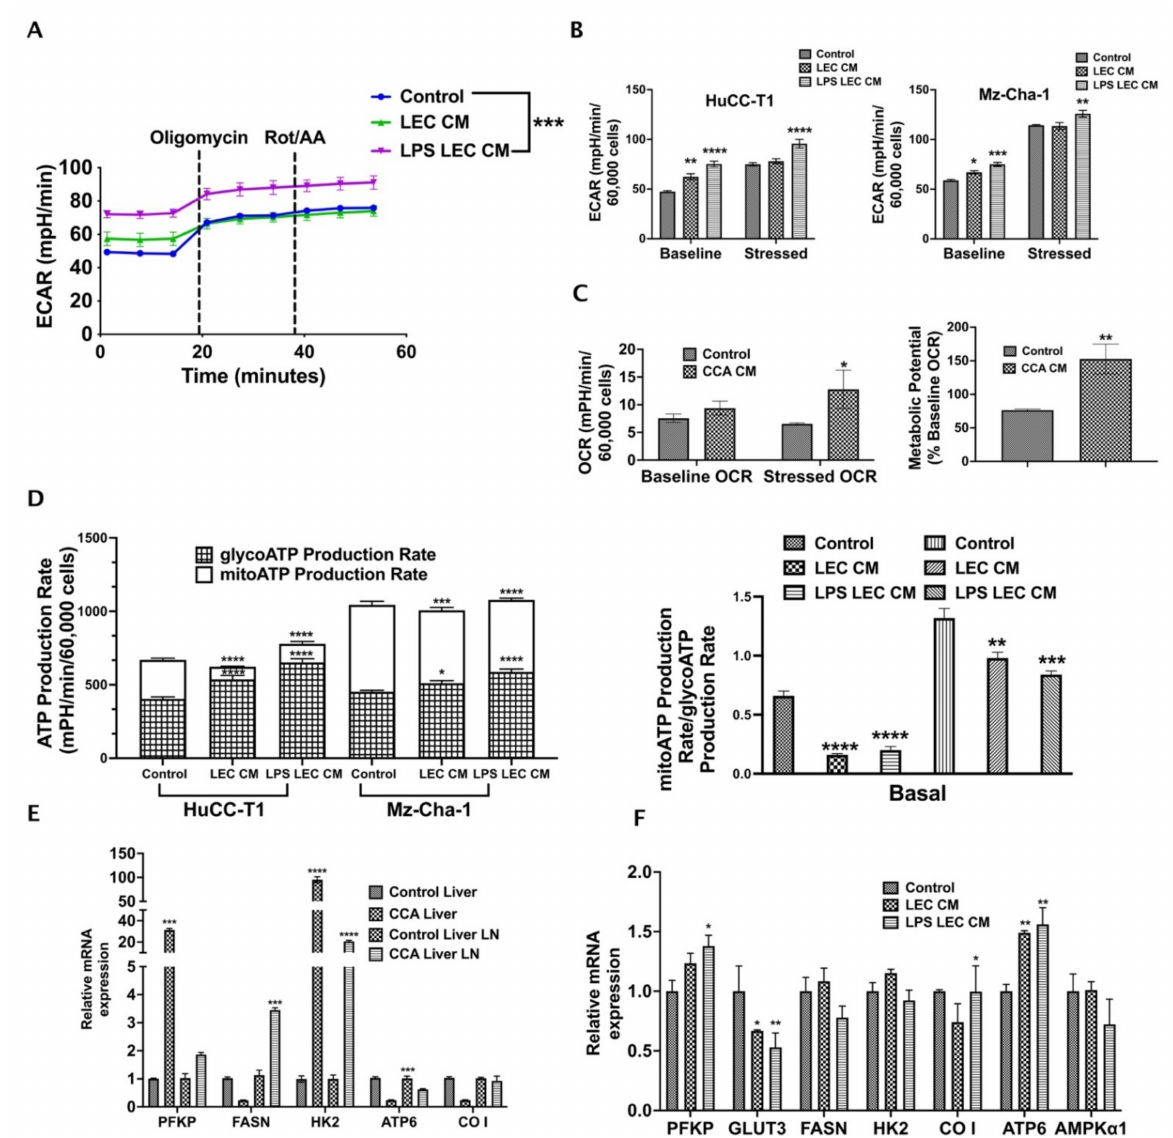
Figure 5. Crosstalk with inflamed LECs alter cellular bioenergetics and critical metabolic gene expression in CCA cells. CCA cells were treated with LEC/LPS-LEC-CM or 5%EGM and Seahorse assay was performed to follow the glycolysis. ( A ) Graph for Extracellular acidification rate (ECAR) of all groups was obtained using Wave software. The time points by which Oligomycin and Rot/AA were injected were depicted in the graphs. The ECAR at time points before Oligomycin injection is associated with glycolysis while that post Oligomycin injection is associated with maximal glycolytic capacity. Values are represented as mean ± SEM, n ≥ 3. *** represents value significantly different than control at p ≤ 0.001 ( B ) Comparison of baseline vs. stressed ECAR between LEC-CM/LPS-LEC-CM treated CCA cells. * p ≤ 0.05, ** p ≤ 0.01, *** p ≤ 0.001 and **** p ≤ 0.0001 represents value significantly different than control. ( C ) Comparison of baseline and stressed OCR in CCA-CM treated LECs. Lower panel, right, shows metabolic potential of CCA-CM LECs. Values are represented as mean ± SEM, n ≥ 3. * p ≤ 0.05 and ** p ≤ 0.01represents value significantly different than control. ( D ) Left panel shows comparison between glycolytic and mitochondrial ATP production rate in LEC-CM/LPS-LEC-CM treated CCA cells. Right panel shows comparison between ATP rate index between LEC-CM/LPS-LEC-CM treated CCA cells. * p ≤ 0.05, ** p ≤ 0.01, *** p ≤ 0.001 and **** p ≤ 0.0001 represents value significantly different than control. Expression of metabolic genes were measured by qPCR in ( E ) CCA cells treated with LEC-CM or LPS-LEC-CM. Values are represented as mean ± SEM, n ≥ 3. *** p ≤ 0.001 and **** p ≤ 0.0001 represents value significantly different than control. ( F ) Liver and LNs from CCA orthotopic mice and control animals. Values are represented as mean ± SEM, n ≥ 3. * p ≤ 0.05 and ** p ≤ 0.01 represents value significantly different than